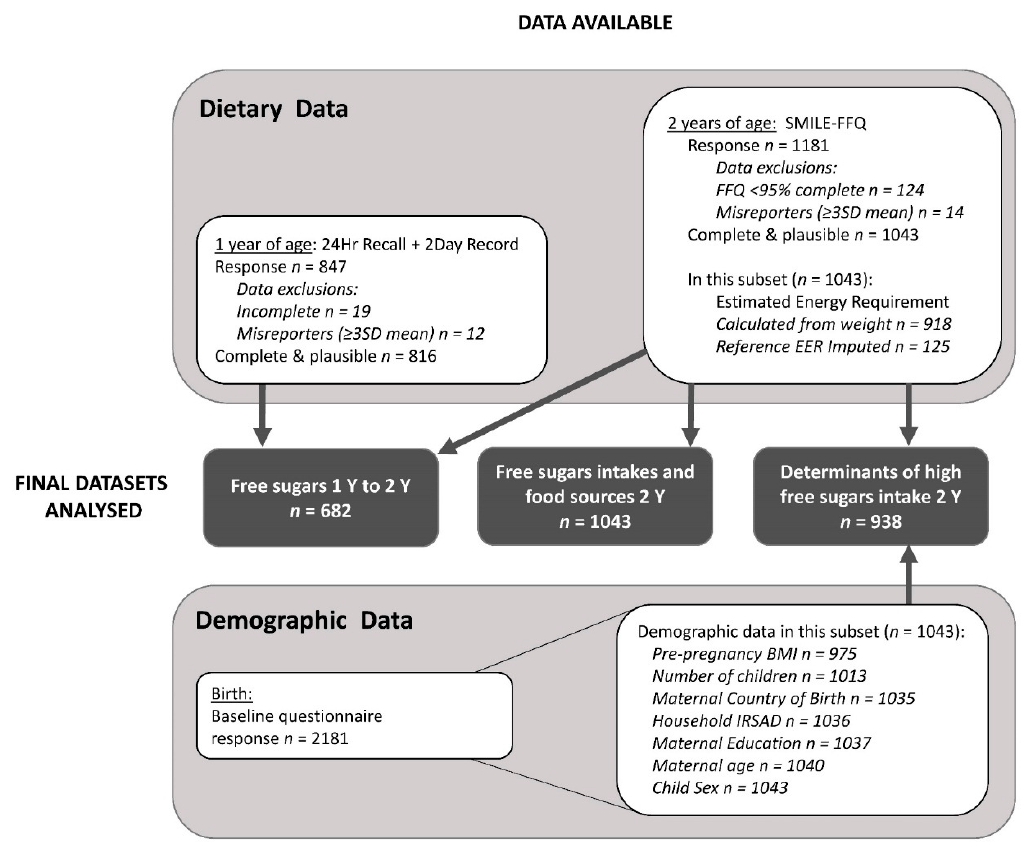
Figure 1. Participant flowchart for the analysis datasets. SMILE-FFQ: Study of Mothers’ and Infants’ Life Events Food Frequency Questionnaire; SD: Standard Deviation; Y: year; BMI: Body Mass Index IRSAD: Index of Relative Socioeconomic Advantage and Disadvantage.